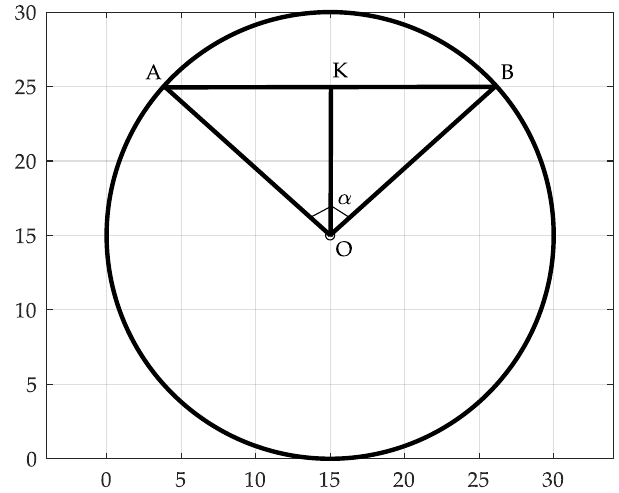
Figure 2. Finding the value of the area of intersection of coverage areas.